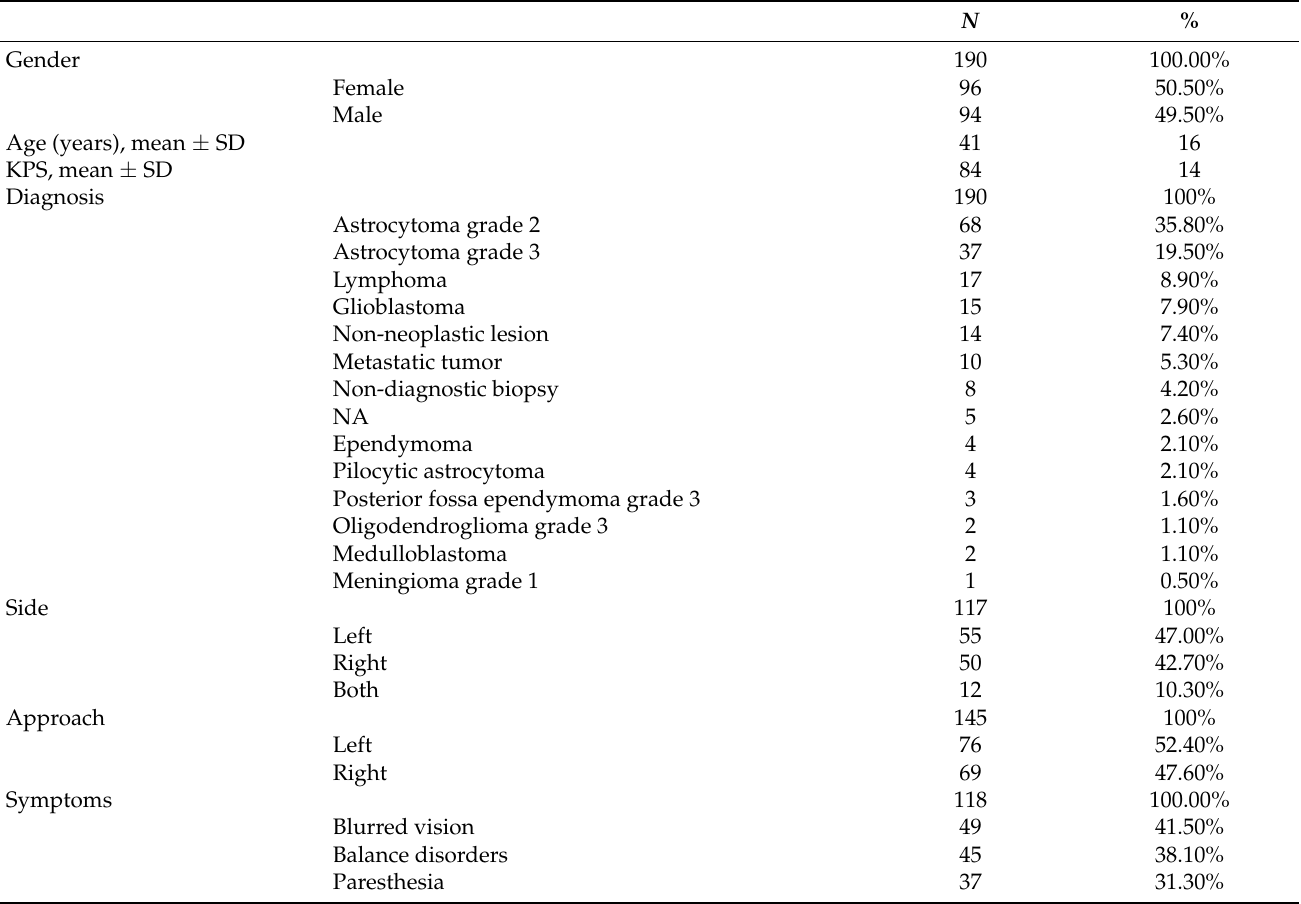
Table 1. Descriptive statistics of the performed